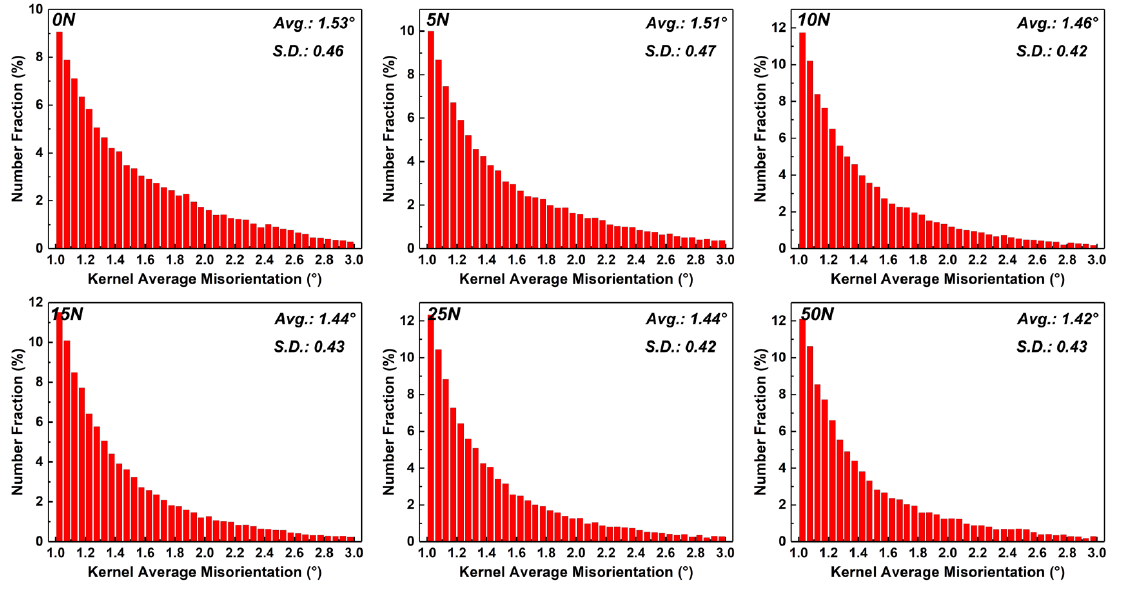
Figure 10. Kernel average misorientation (KAM) distribution histograms in the inner wall region of extruded samples with different N based on electron backscatter diffraction (EBSD) statistics.